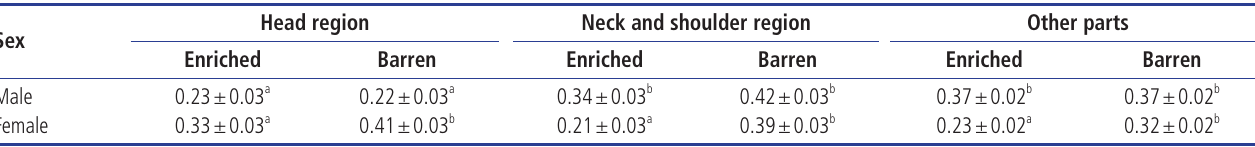
ab Values with different superscripts across the treatments differ significantly